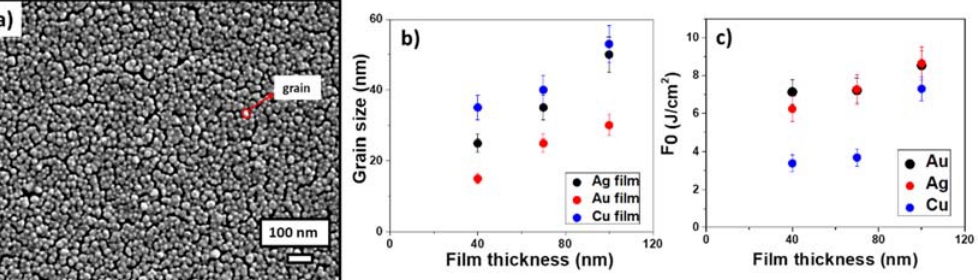
Figure 2. SEM visualization of the 100-nm thick Au film on the donor polymer substrate ( a ); grain dependence on the film thickness for silver, copper and gold films ( b ); and dependence of the LIFT threshold fluence (F 0 ) on the metal film thickness ( c ).